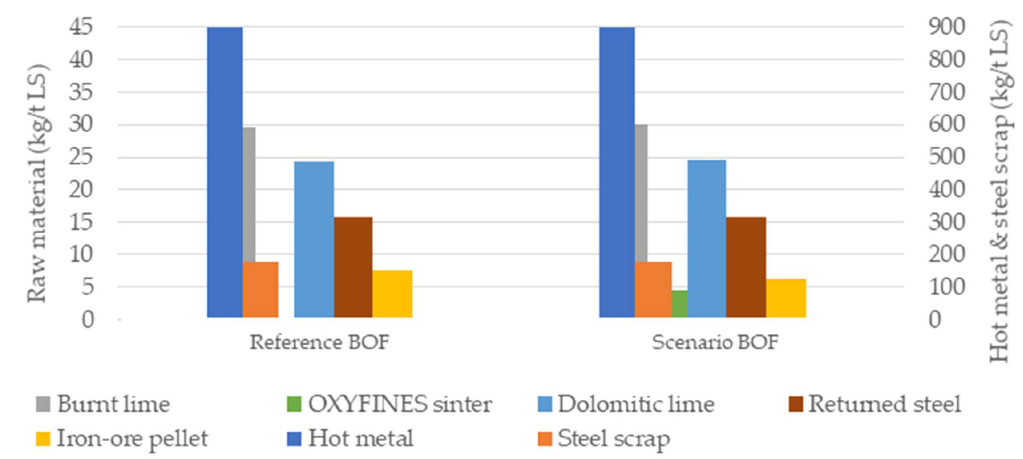
/ tLS) from using the OXYFINES